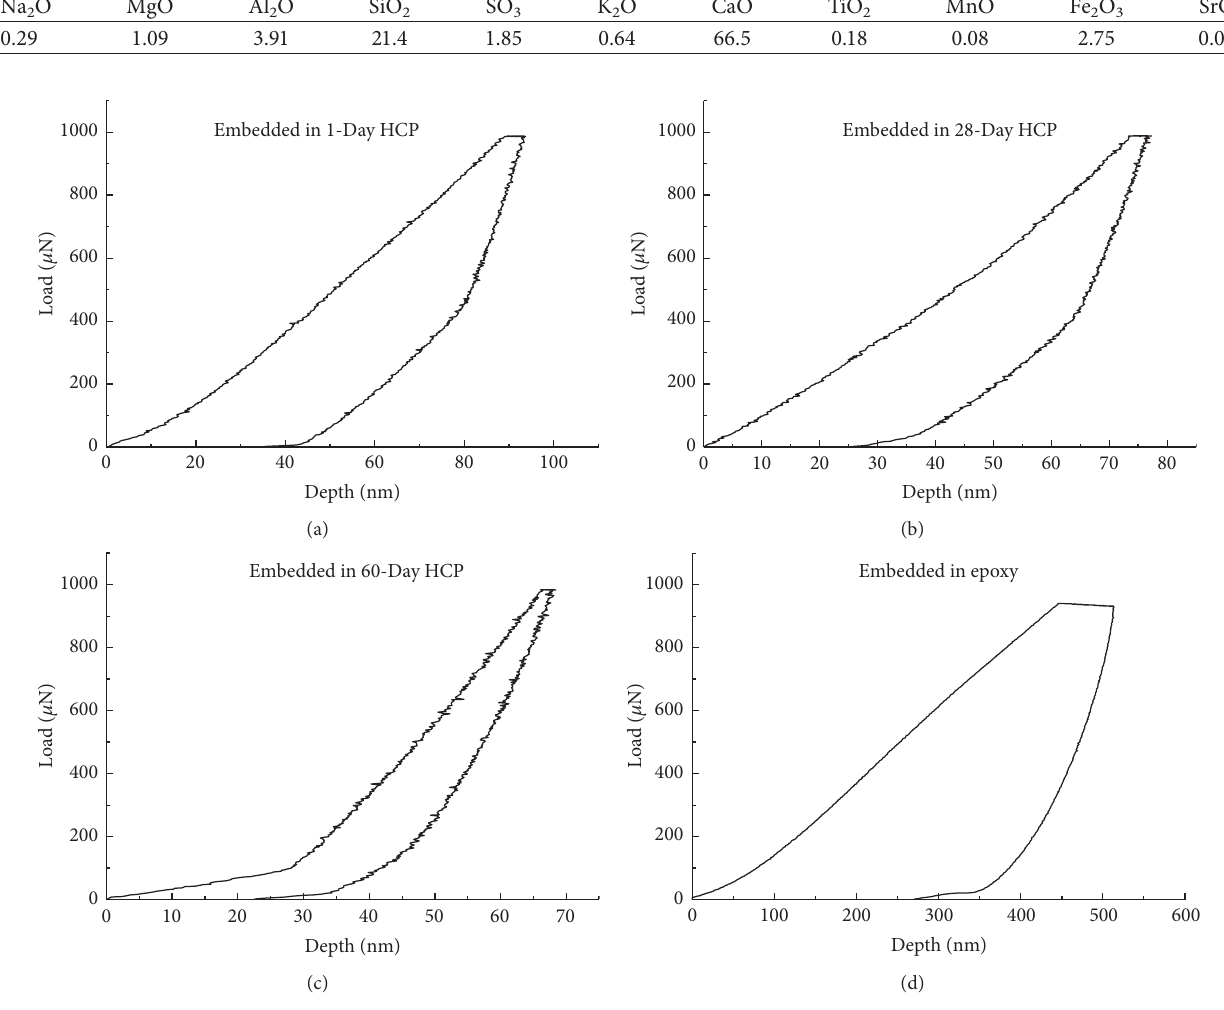
Figure 1: Typical load-depth curves of cement particles. Table 2: NI results of cement particles under different embedded conditions.